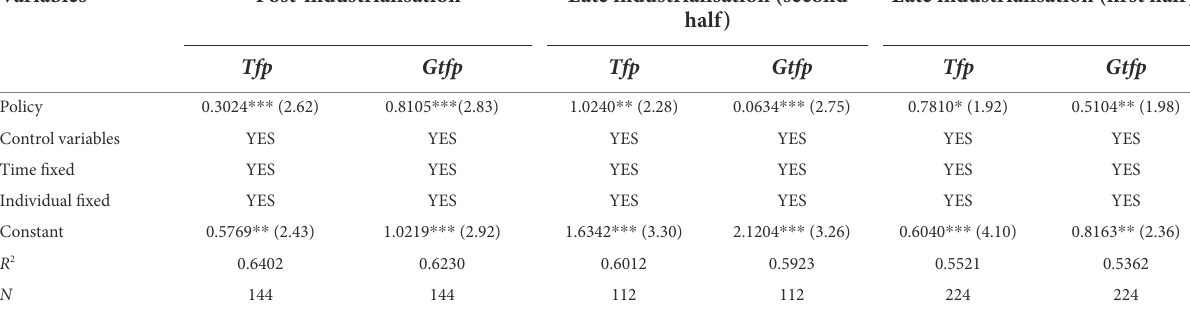
TABLE 9 Regression results for the impact of different stages of industrialisation development.